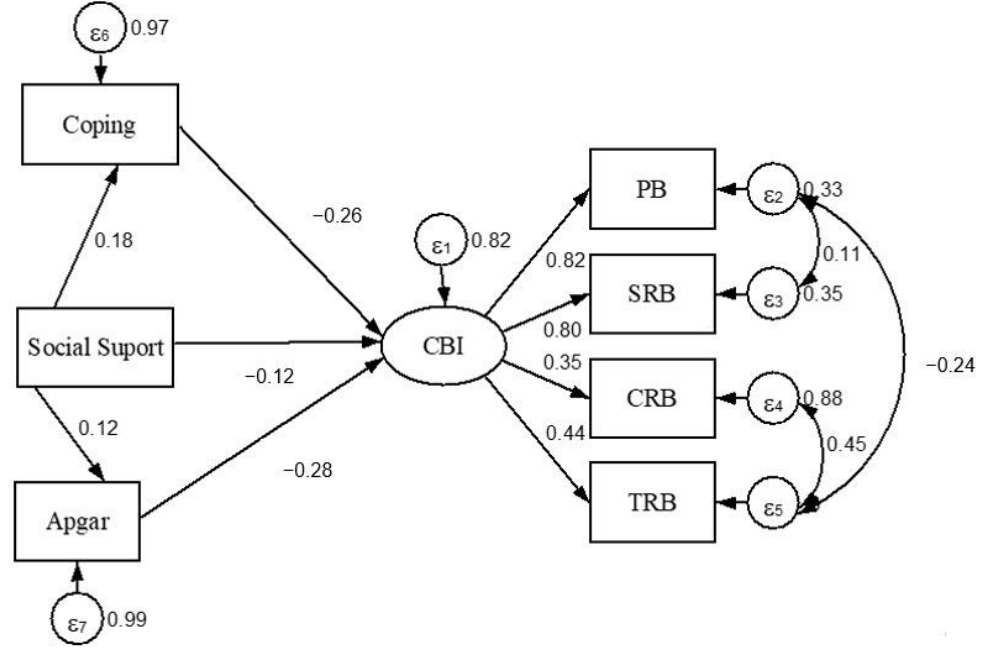
Figure 1. Visual representation of the structural model. CBI: Copenhagen Burnout Inventory-Stu- dent; PB: Personal Burnout; SRB: Studies-related Burnout; CRB: Colleague-related Burnout; TRB: Teacher-related Burnout.